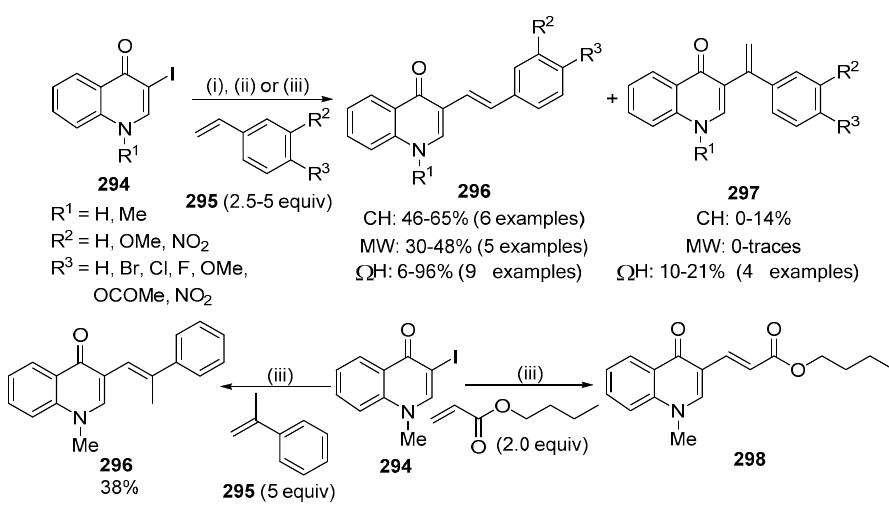
Scheme 93. Synthesis of ( E )-3-substituted-quinolin-4(1 H )-ones 296 , 297 and 298 by Heck reaction of 3-iodoquinolin-4(1 H )-ones 294 with styrenes 295 and butyl acrylate, respectively [119,122].